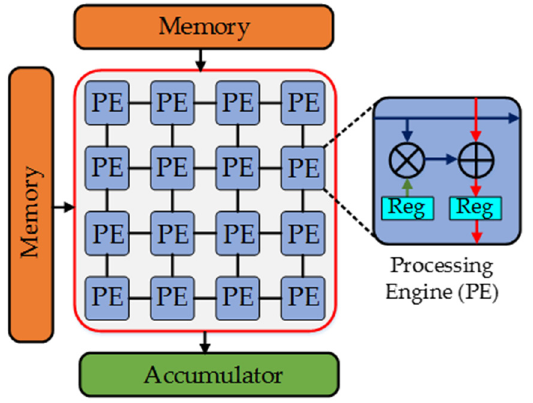
Figure 11. Hardware block diagram showing the generic structure of a spatial architecture.